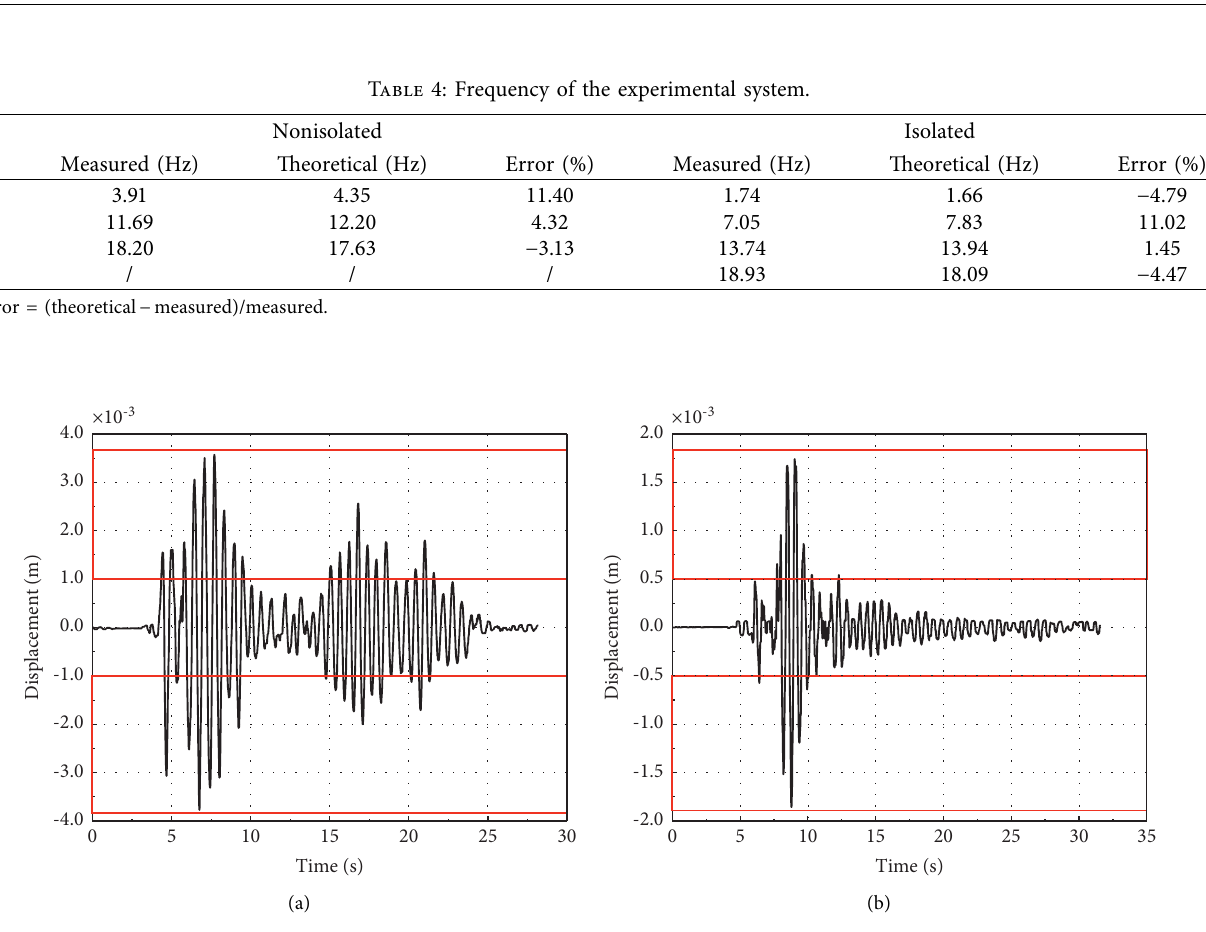
Figure 3: Displacement of the isolation layer (PGA � 0.07g). Isolation displacement of (a) case 211 and (b) case